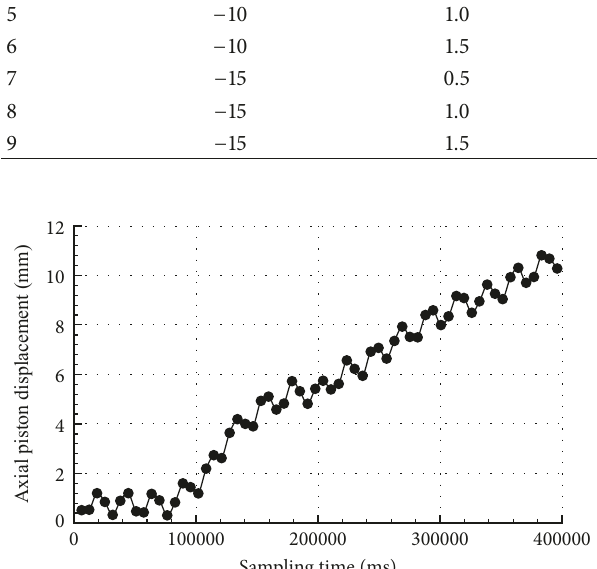
Figure 2: Displacement of piston under axial load ( T 0.5 MPa, and A f 0.2Hz, σ 3 (cid:31) (cid:31)